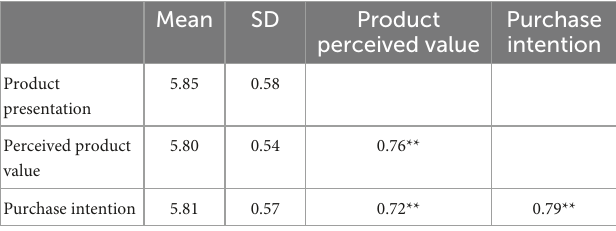
TABLE 2 Description and correlation of variables in Study 1.